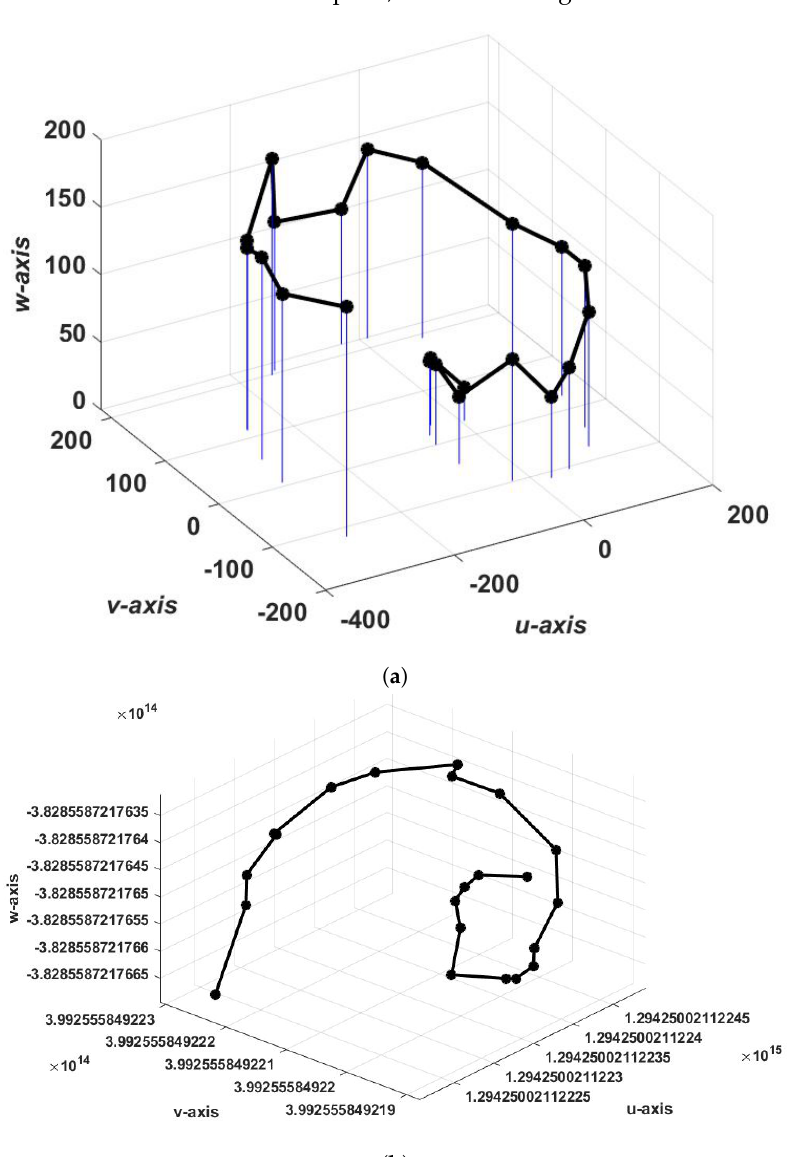
Figure 5. 3D user template ( a ) Initial 3D template, blue lines are the applicate values computed by us- ing the secured ridge count src j and k 3 , ( b ) Final 3D user template after the user curve